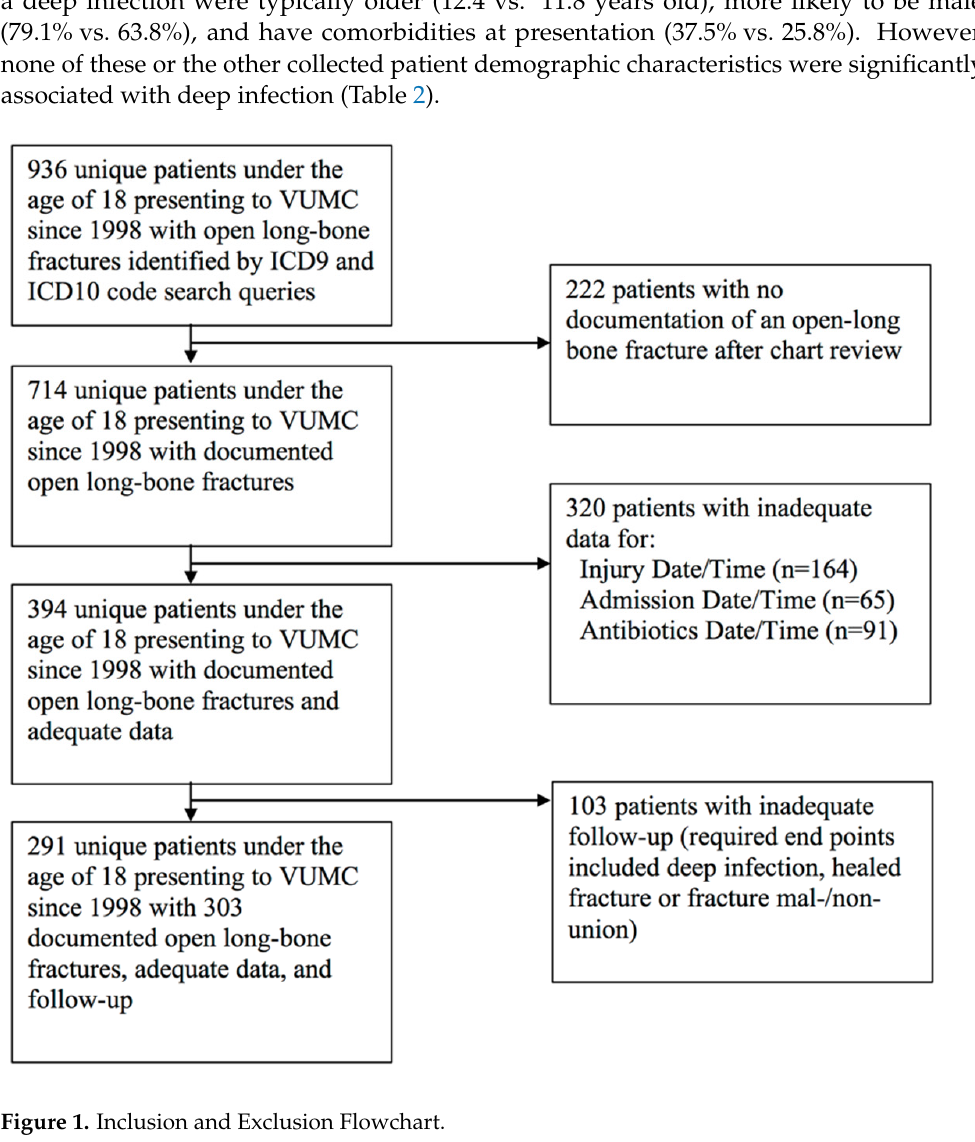
Figure 1. Inclusion and Exclusion Flowchart. Table 2. Patient Demographic Characteristics.